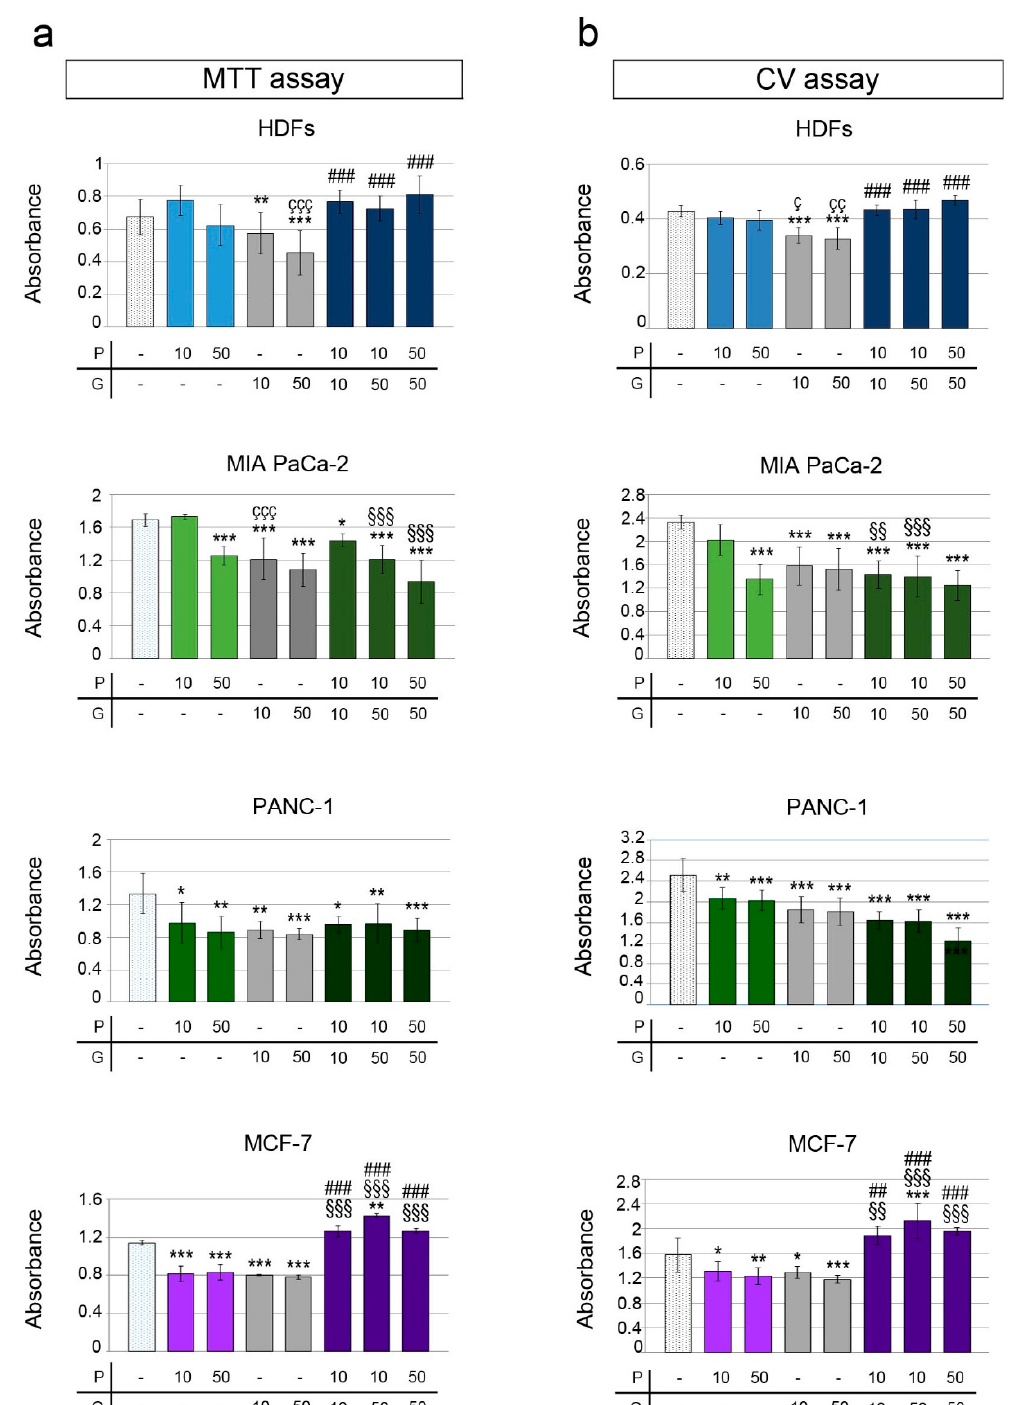
Figure 2. Impact of different PRO/gemcitabine (GEM) combinations on cell viability of HDFs, MIA PaCa-2, PANC-1 and MCF-7 cells. Cell viability of HDFs, MIA PaCa-2, PANC-1 and MCF-7 cells was assessed by MTT ( a ) or crystal violet (CV) assay ( b ). PRO and GEM doses ( µ M) used in treatments are indicated in x -axis. Graph columns represent mean of absorbance ± SD ( a , b ). The symbol * indicates statistical significance of any treatment versus control group; ç, statistical significance of GEM versus the corresponding concentration of PRO; §, #, statistical significance of PRO/GEM combinations versus the corresponding concentration of PRO or GEM, respectively. P = protopine; G = gemcitabine. *, ç p < 0.05; **, çç, §§, ## p < 0.01; ***, ççç, §§§, ### p < 0.001.